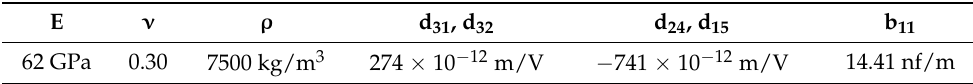
Table 2. Material properties of the piezoelectric